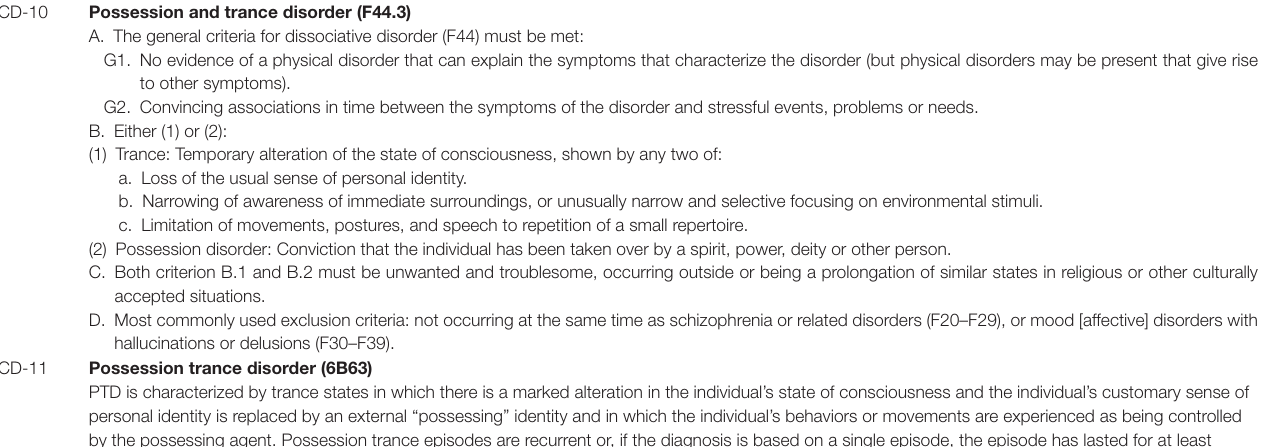
TABLE 1 | References to possession in ICD-10, ICD-11, and DSM-5.